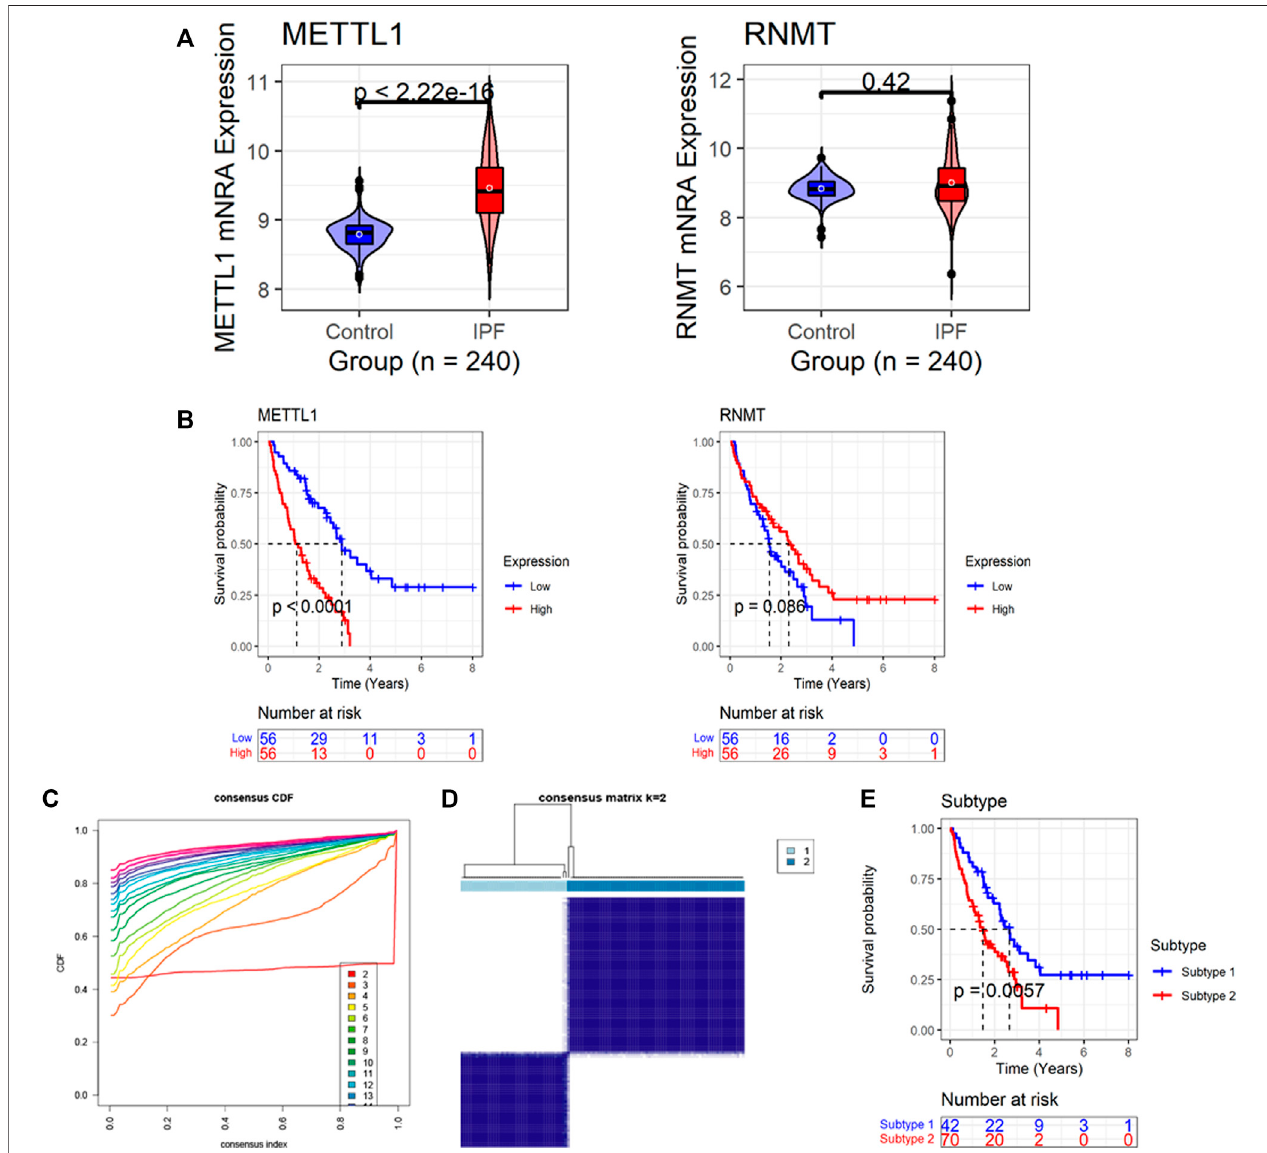
FIGURE 2 | The expression and prognostic signi fi cance of m7G regulatory genes (m7GRGs) in IPF. (A) Differences in expression of m7GRGs between IPF and normalbronchoalveolarlavagecells(syntheticminorityoversamplingtechniquedatawereusedinthispanel);the p -valueiscalculatedbasedonWilcoxonrank-sumtest. (B) The association of m7GRGs expression levels with the prognosis of IPF patients; the p -value is calculated based on log-rank test. (C) The cumulative distribution function plot demonstrates that among 2 – 20, the optimal k value of subtypes equals 2. (D) Heatmaps of the consensus matrices for k = 2; the panel shows that patients can be signi fi cantly divided into two subtypes (42 patients in the subtype 1, and 70 patients in the subtype 2). (E) The different prognosis between the two subtypes; the p -value is calculated based on log-rank